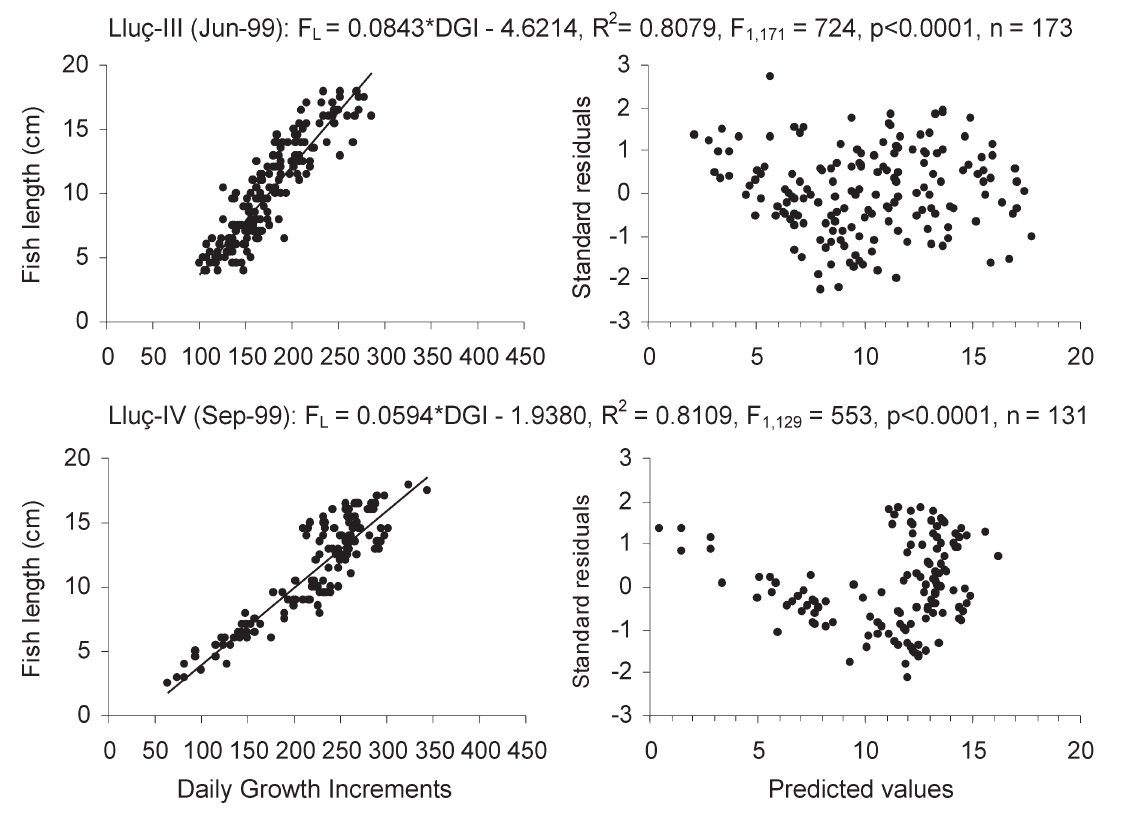
F IG . 7. – Regression of fish total length versus daily growth increments and plots of residuals versus predicted values from juvenile Merluccius merluccius captured on each